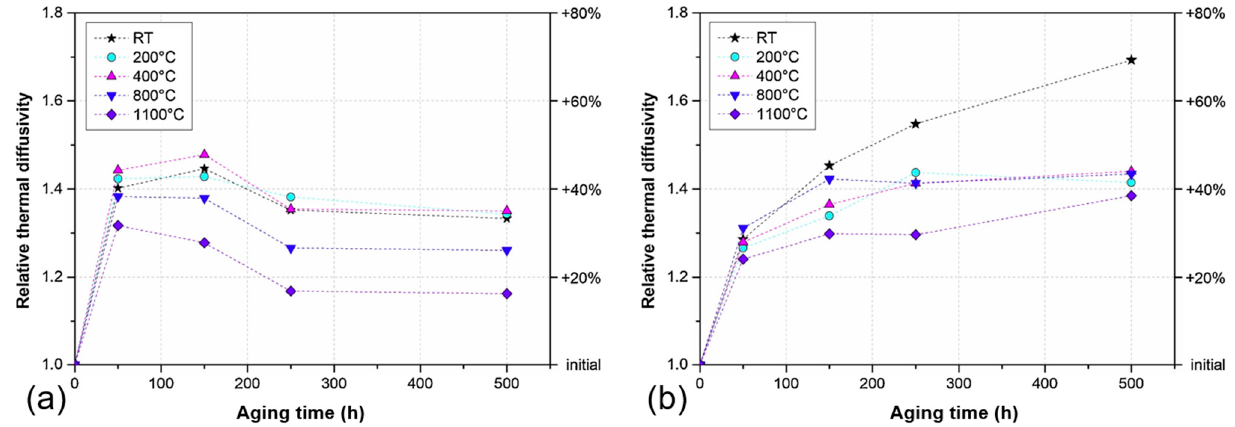
Figure 15. Normalized thermal diffusivity of TBCs as a function of isothermal heat treatment time at 1100 °C ( a ) freestanding coatings ( b ) full TBCs [92] .